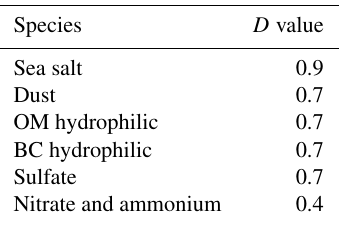
Table 10. Value of the parameter D , representing the fraction of aerosol included in a cloud